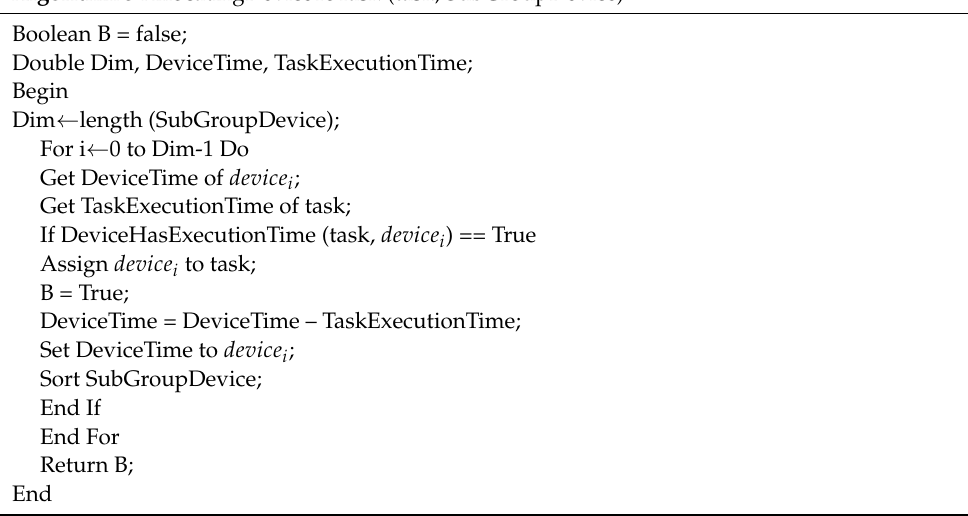
Algorithm 3 AllocatingDeviceToTask (task,